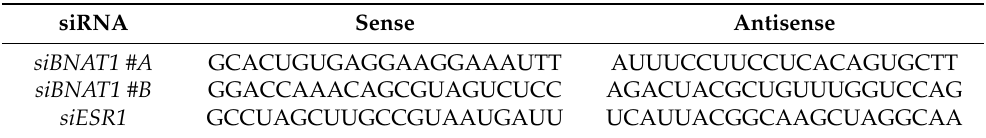
Table 2. siRNAs used in this